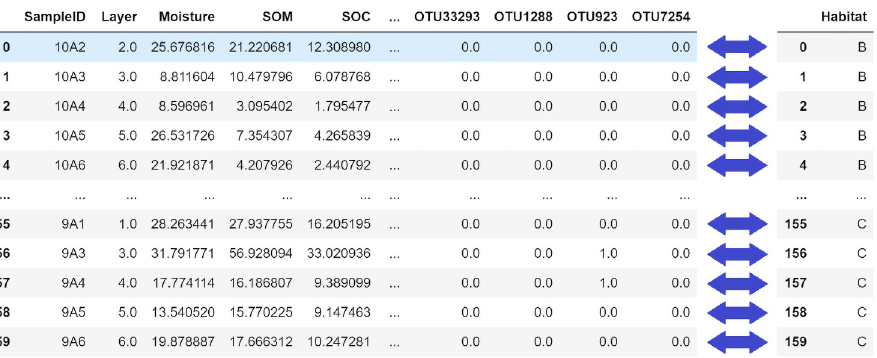
Fig 2. Printout of pandas dataframes containing raw data collected directly from ecological sites. (Left) Dataframe containing raw input variables. (Right) Dataframe containing output class labels.